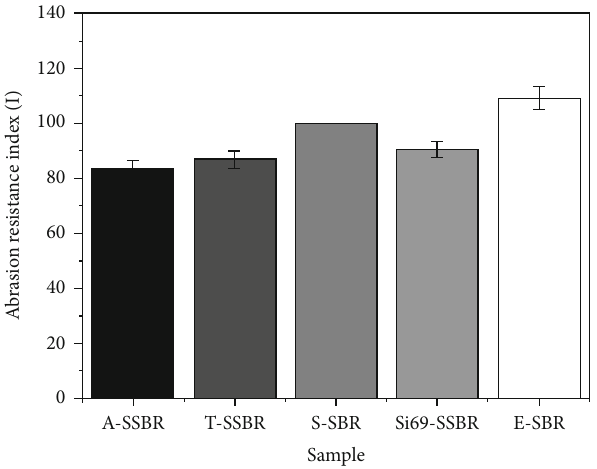
Figure 8: The abrasion test results of the samples.